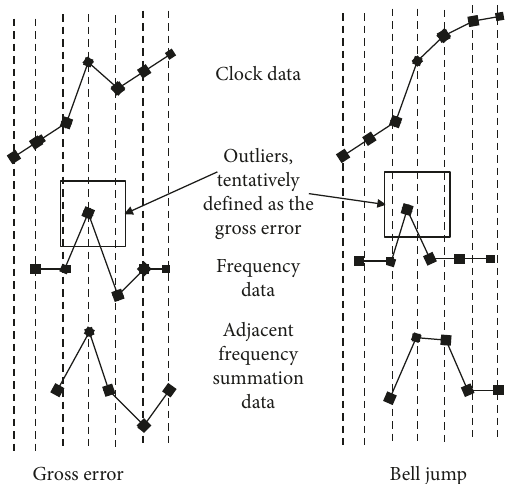
Figure 4: Schematic diagram of the difference between gross errors and clock jumps in satellite clock